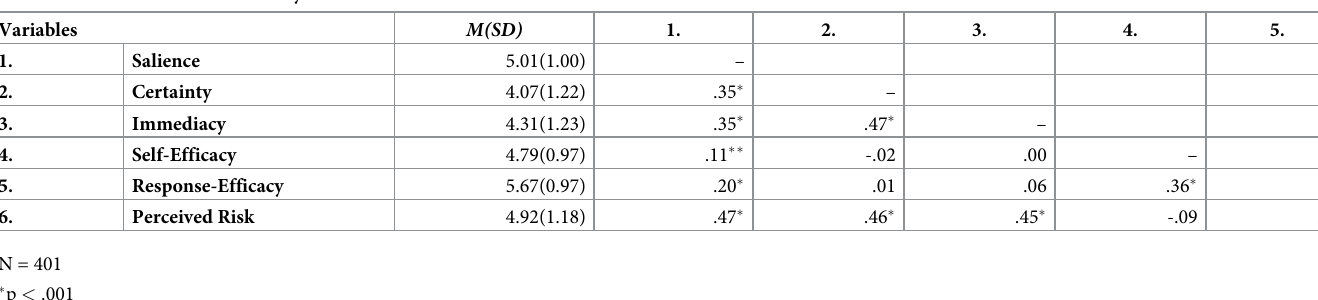
Table 3. Bivariate Correlation Analysis.